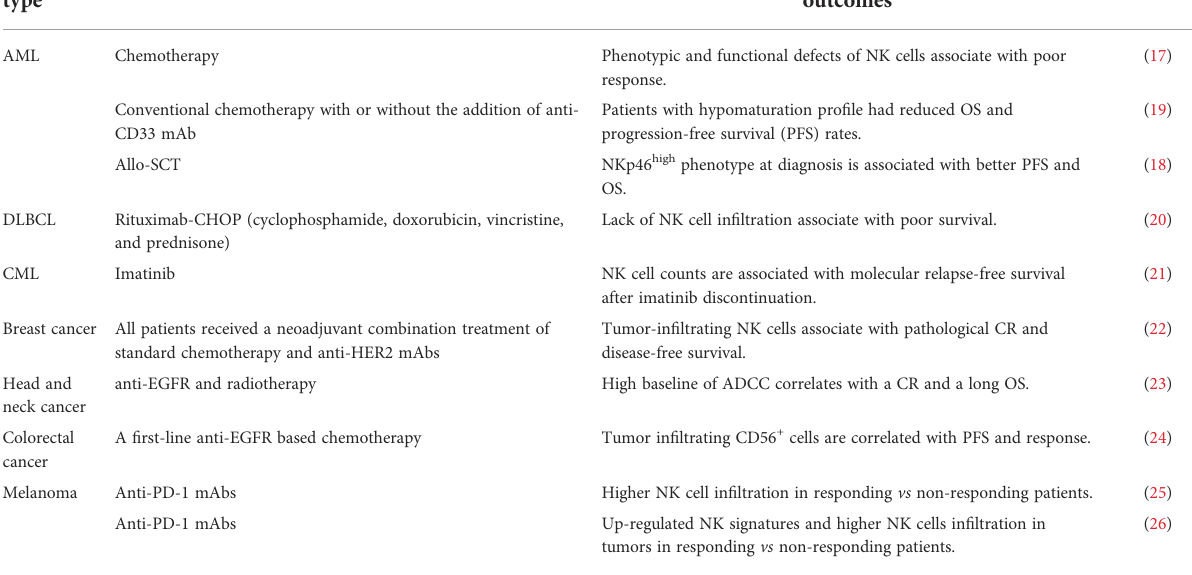
TABLE 1 Clinical correlations of NK cells with patient